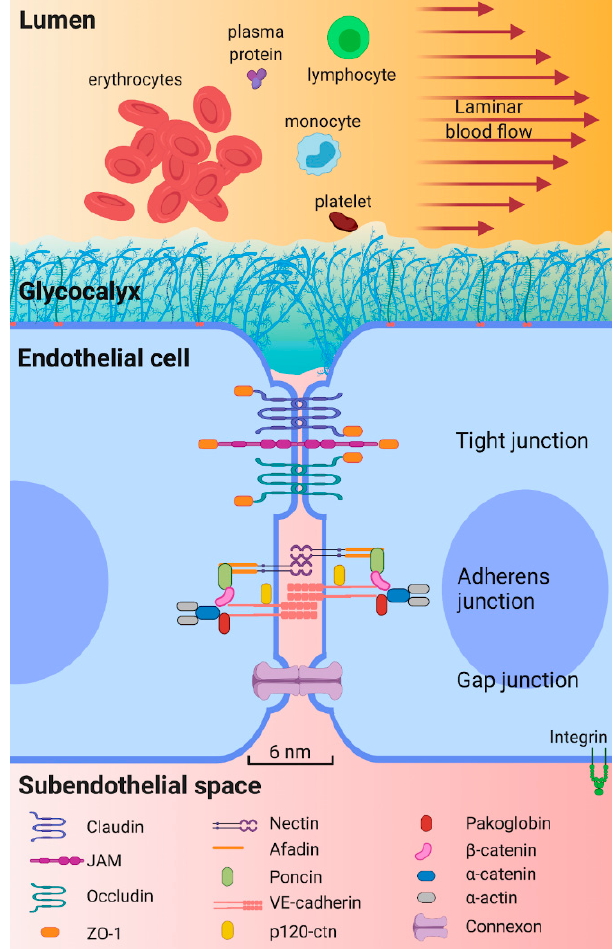
Figure 2. Key structures for epithelium permeability. The arterial endothelium is a semipermeable barrier that prevents passage of blood cells and large molecules from circulating blood to subendothelial space. The glycocalyx and junction complexes are the main structures that help to maintain this function. The glycocalyx, covering the luminal surface of endothelium, comprises proteoglycans, glycosaminoglycans and glycoproteins. Proteoglycans are syndecanes 1, 2 and 4, glypican and perlecan; the main glycosaminoglycans are heparan sulfate, chondritin sulfate, and hyaluronic acid; glycoproteins, involve three families of adhesion molecules, selectin family, the integrin family, and the immunoglobulin superfamily, and their expression depends on the surrounding microenvironment. There are three subtypes of junction complexes connecting adjacent EC. Tight junctions are formed by claudins, junction adhesion molecules (JAM), and occludins. Tight junctions bind to zonule occludens-1 (ZO-1), allowing interaction with cytoskeleton components. Second, adherens junctions are formed by nectin, poncin, afadin, and vascular endothelial cadherin (VE-cadherin) complexes. VE-cadherin binds to filamentous actin (F-actin) via intracellular proteins such as pacoglobin, β -catenin, α -catenin, and α -actin. Third, gap junctions consist of two connexons that form an intercellular channel that physically communicates adjacent endothelial cells (EC) and allows passive diffusion of ions and small molecules